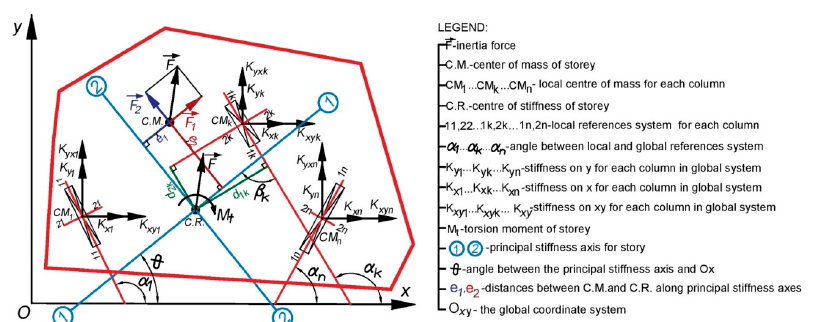
Figure 2. Representation of the physical signification of the stiffness factors.